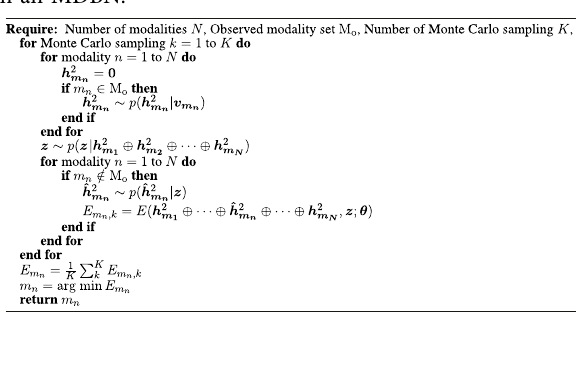
Algorithm 1. Active inference based on energy minimization